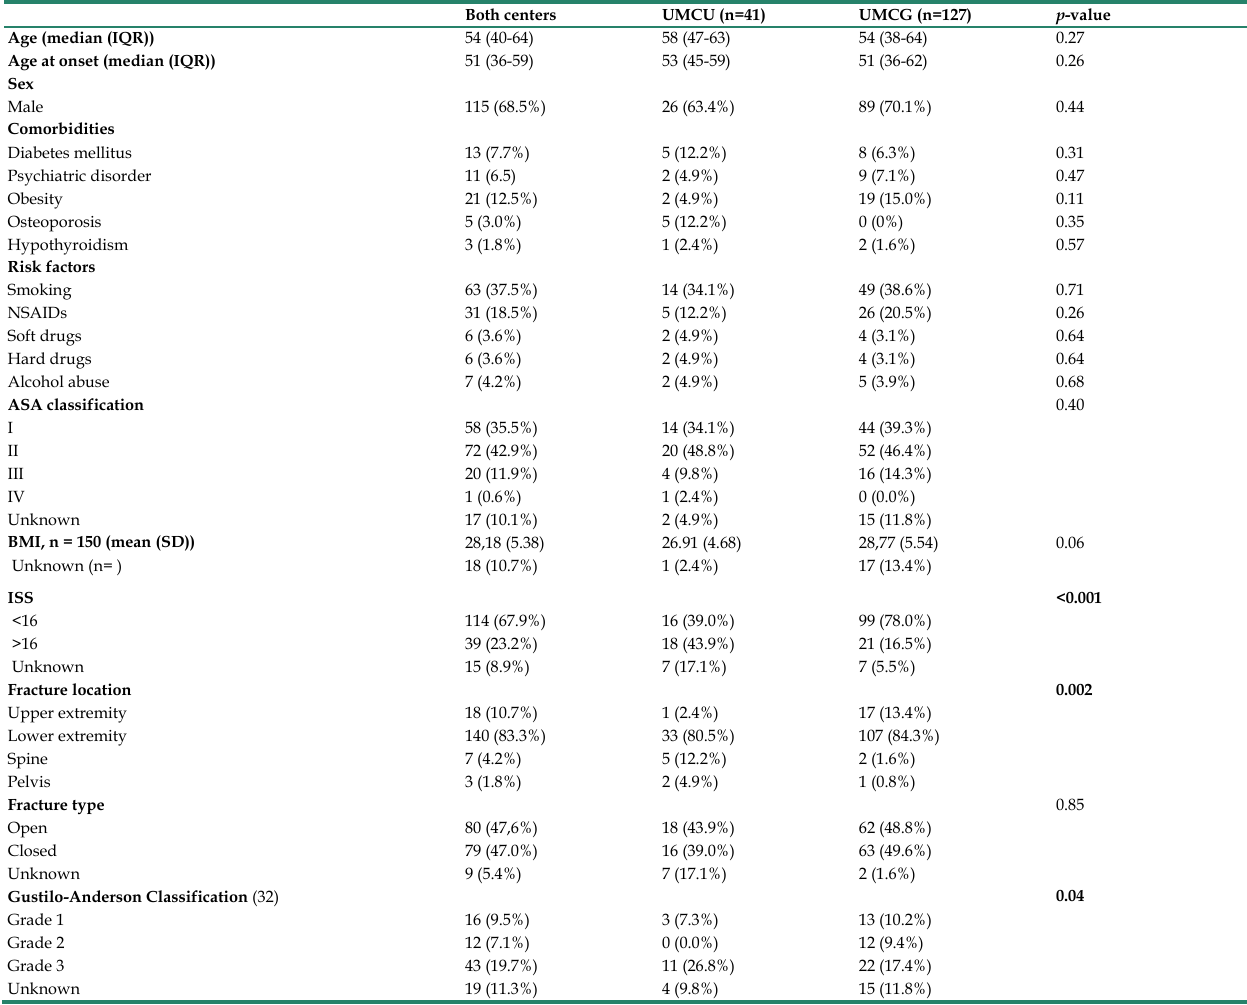
Table 2. Baseline characteristics of study population.